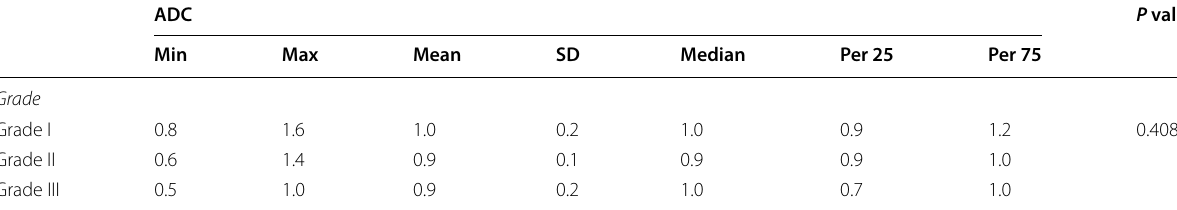
Table 3 Comparison of ADC regarding